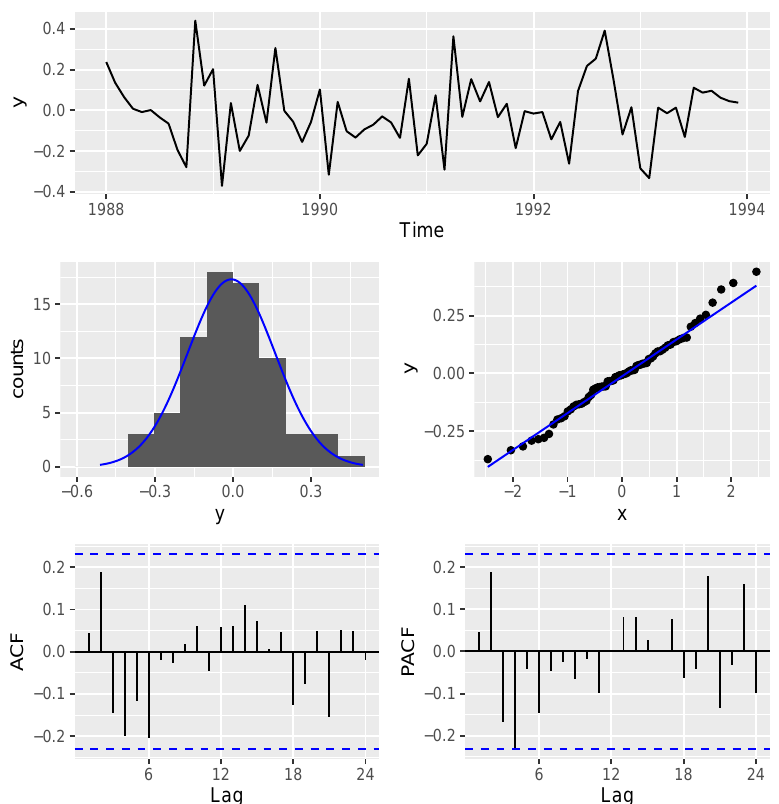
Figure 3. Diagnostic plots for the souvenir forecast errors. The upper plot shows a time-series plot, which reveals evidence of stationarity. The middle plots are the histogram ( middle-left ) and the quantile–quantile plot ( middle-right ), both plots suggest that the time series process has a normal distribution. The lower plots show the autocorrelation functions, and for both plots, the autocorrelations are close to zero, giving further evidence of